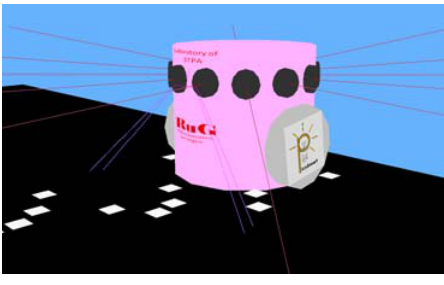
Figure 6. Details of a mobile sensor.